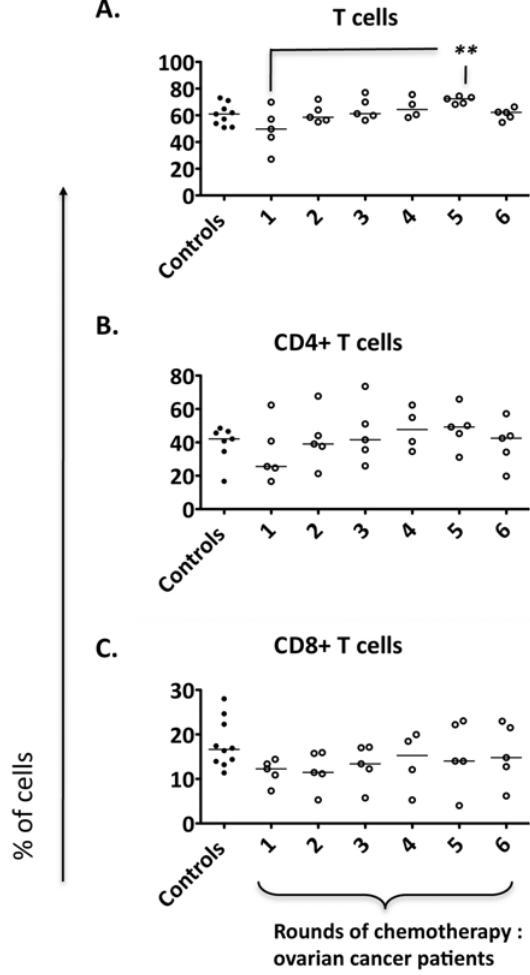
Figure 1. Major subsets within the PBMCs of ovarian cancer patients over the course of standard chemotherapy. Peripheral blood from five ovarian cancer patients was collected over the course of the standard chemotherapeutic treatment. PBMCs of patients and controls (n = 10) were isolated and flow cytometry was performed to determine ( A ) the T cell (CD3+ CD56 − ) frequency within PBMCs; ( B ) the CD4+ T cell frequency within the T cell fraction ( C ) CD8+ T cell frequency within the T cell fraction. Comparison of the frequency of cell populations between patients and controls: ** p <